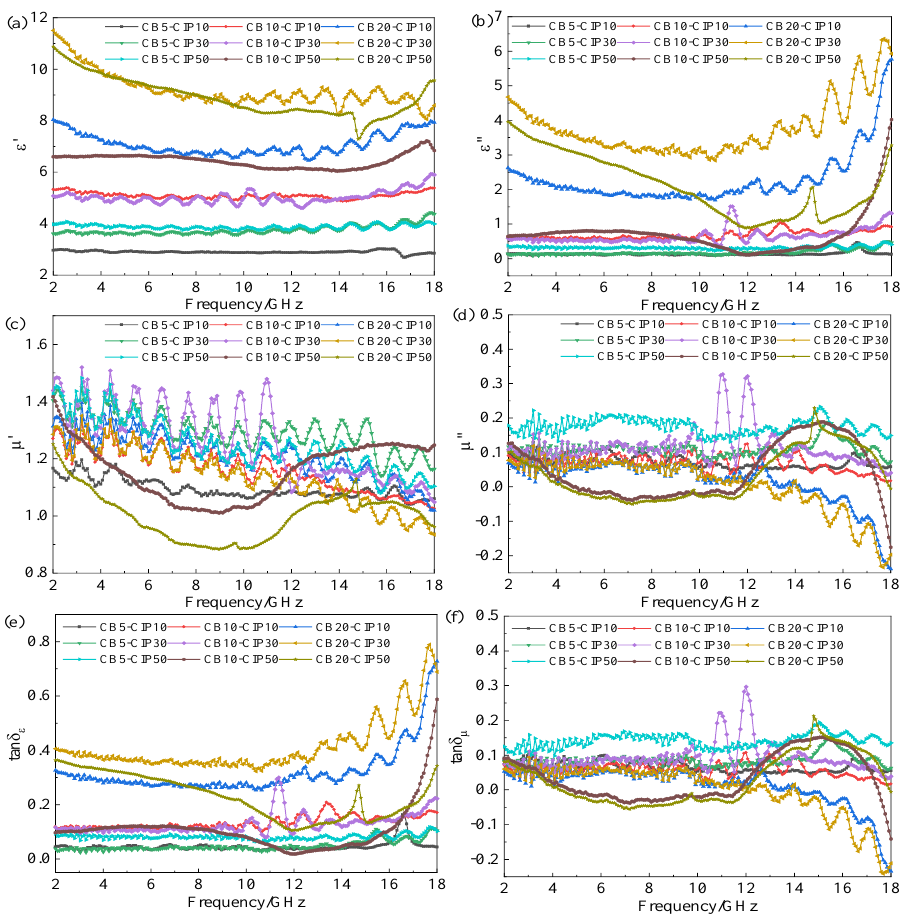
Figure 3. Electromagnetic parameters of different CB − CIP/PLA composites: ( a ) real part of complex permittivity; ( b ) imaginary part of complex permittivity; ( c ) real part of complex permeability; ( d ) imaginary part of complex permeability; ( e ) dielectric loss tangent; ( f ) magnetic loss tangent.